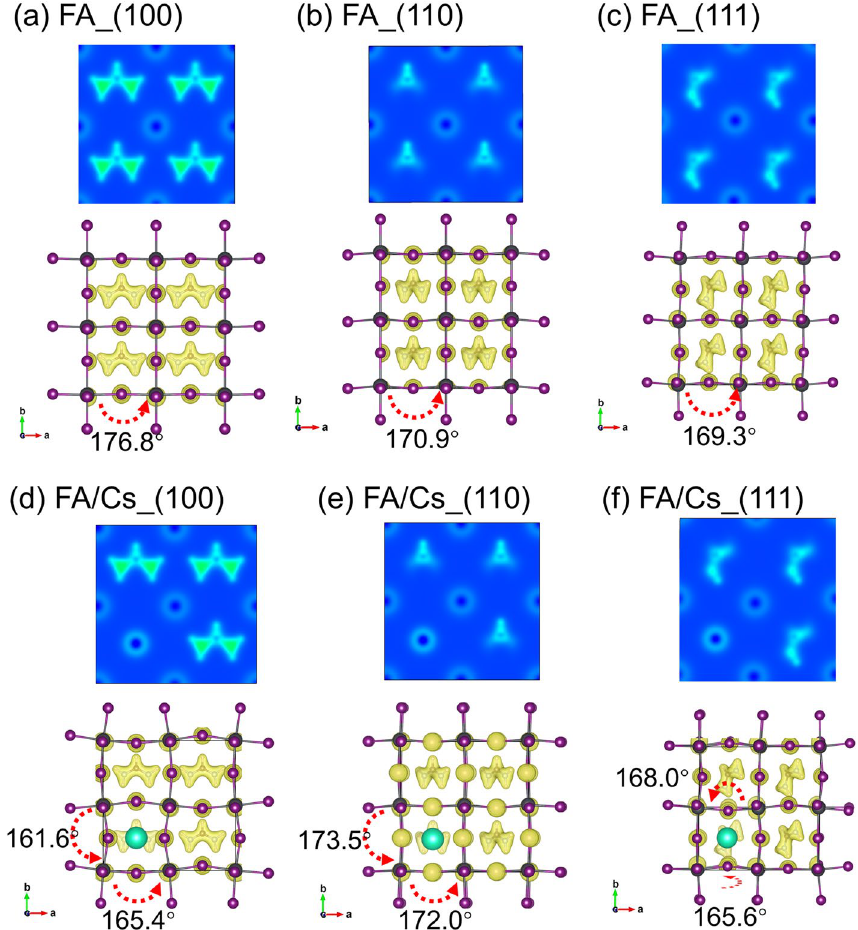
Figure 3. Two-dimensional (2D) depiction of electron charge density in crystallographic plane of (001) in